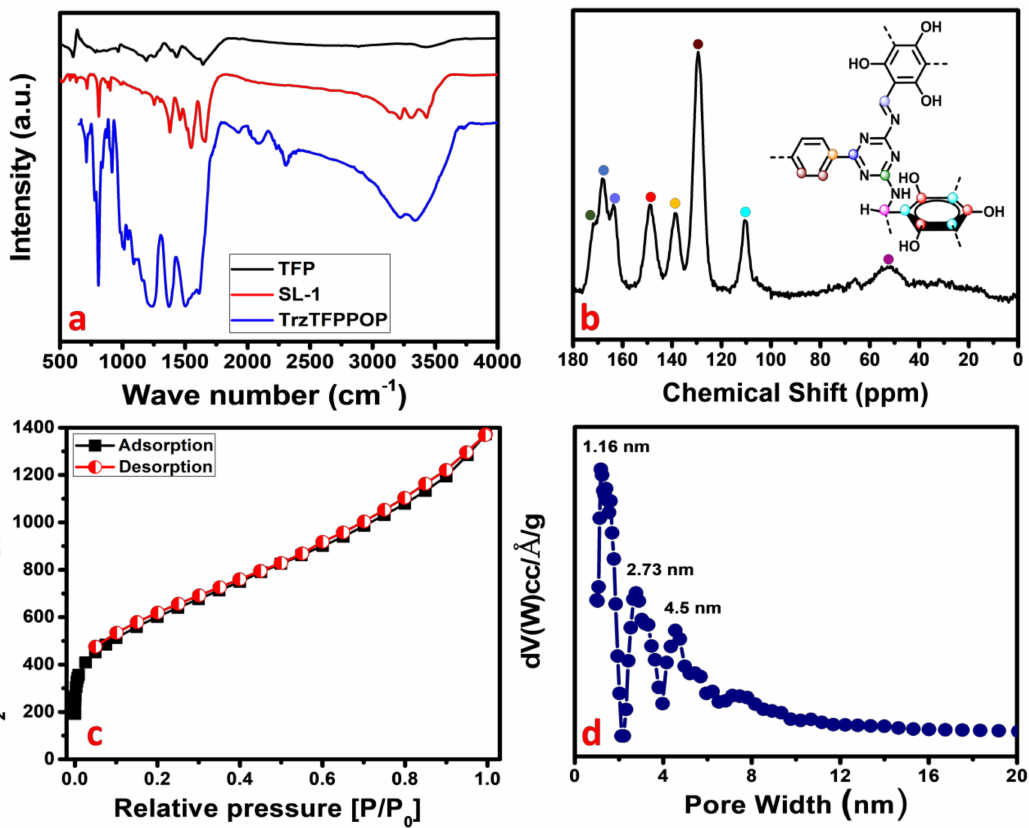
Figure 1. FTIR spectra ( a ); solid-state 13 C MAS-NMR ( b ); N 2 adsorption/desorption isotherm ( c ); and corresponding pore size distribution ( d ) of